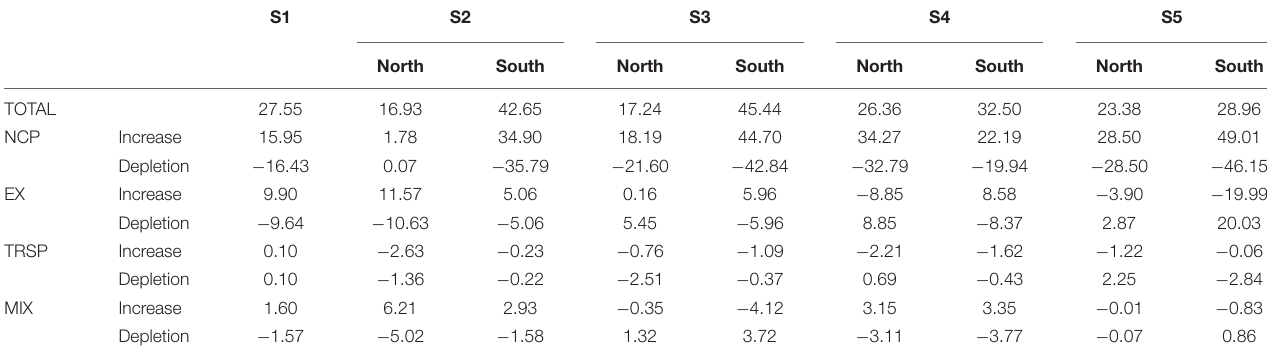
FIGURE 4 | Monthly change in NC T ( (cid:49) NC T /dt; black) and relative contribution of net community production ( (cid:49) NC T /dt| NCP ; green), air-sea exchange ( (cid:49) NC T /dt| EX ; blue), horizontal transport ( (cid:49) NC T /dt| TRSP ; purple), and vertical mixing ( (cid:49) NC T /dt| MIX ; orange) in an entire annual cycle. The temporal variation of NC T was evaluated in S1 (A) and in the northernmost and southernmost part of S2 (B) , S3 (C) , S4 (D) , and S5 (E) . The net contribution of each term in the increase and depletion of NC T is shown in Table 4 . TABLE 3 | Seasonal change of NC T ( (cid:49) NC T /dt) and net contribution of the net community production ( (cid:49) NC T /dt| NCP ; green), air-sea exchange ( (cid:49) NC T /dt| EX ; blue), horizontal transport ( (cid:49) NC T /dt| TRSP ; purple), and vertical mixing ( (cid:49) NC T /dt| MIX ; orange) in the increase and depletion of NC T at stations S1–S5.